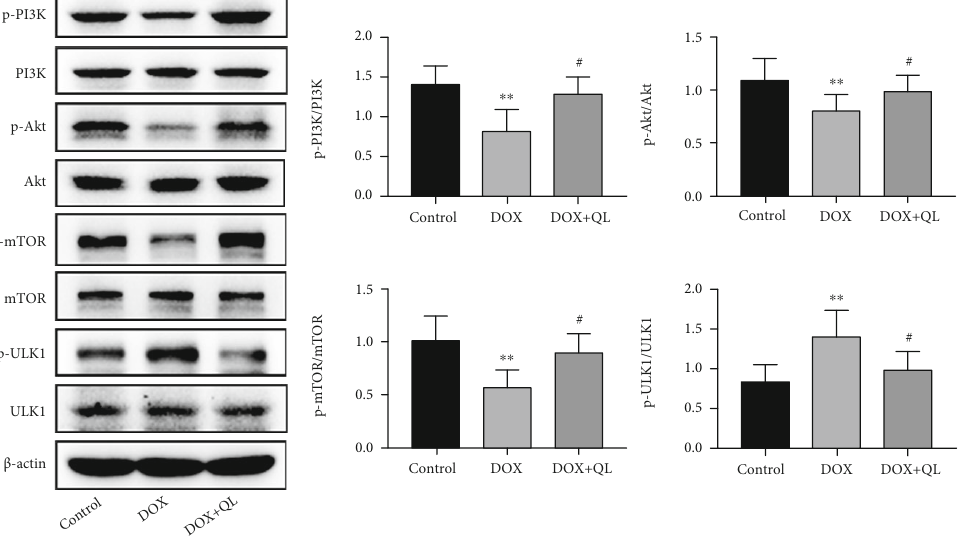
Figure 7: QL activated cardiac PI3K/AKT/mTOR signaling pathway in DOX-treated rats. The expression levels of p-PI3K, PI3K, p-Akt, Akt, p-mTOR, mTOR, p-ULK1, and ULK1 in di ff erent group heart tissues by western blot ( n = 6 ) (values are presented as mean ± SD , ∗∗ P < 0 : 01 vs. control group; # P < 0 : 05 vs. DOX